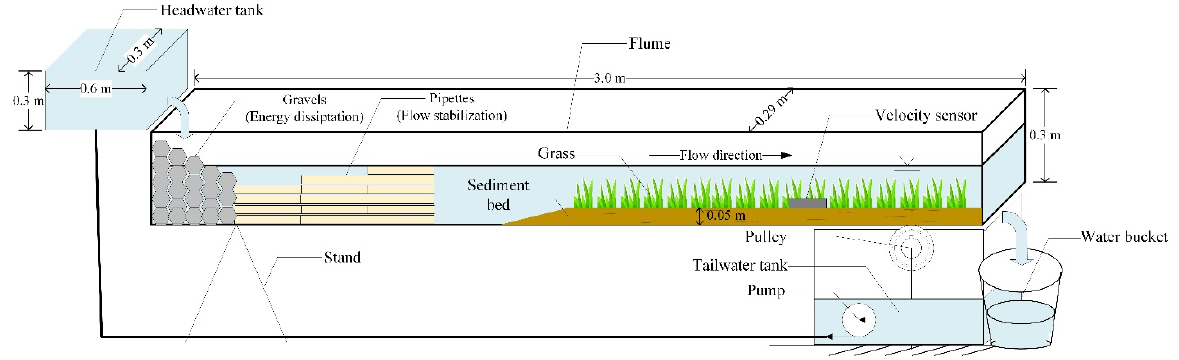
Figure 1. Setup of the flume experiment apparatus.